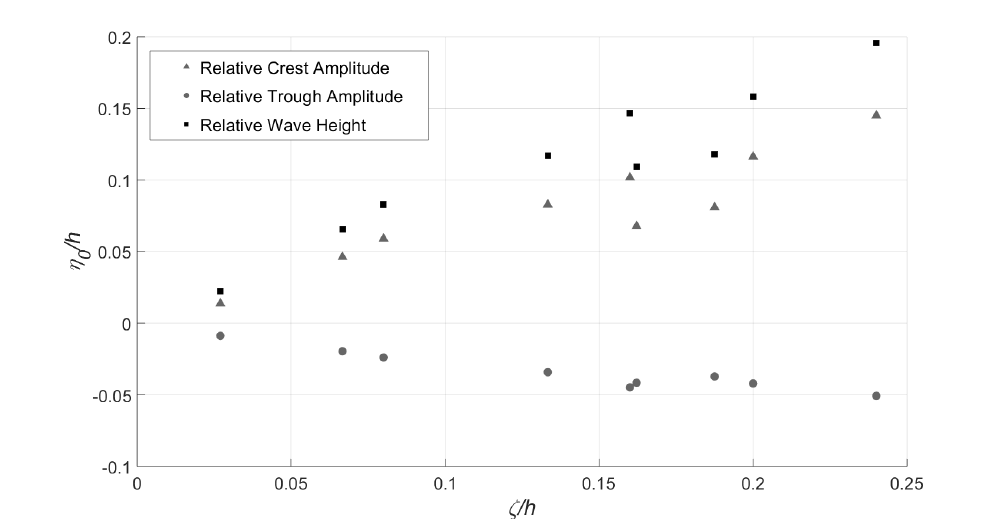
Figure 9. Relative crest and trough amplitudes ( η 0 / h ) at WG2 as a function of displacement scales for IU only. Note that the squares represent the relative wave height.